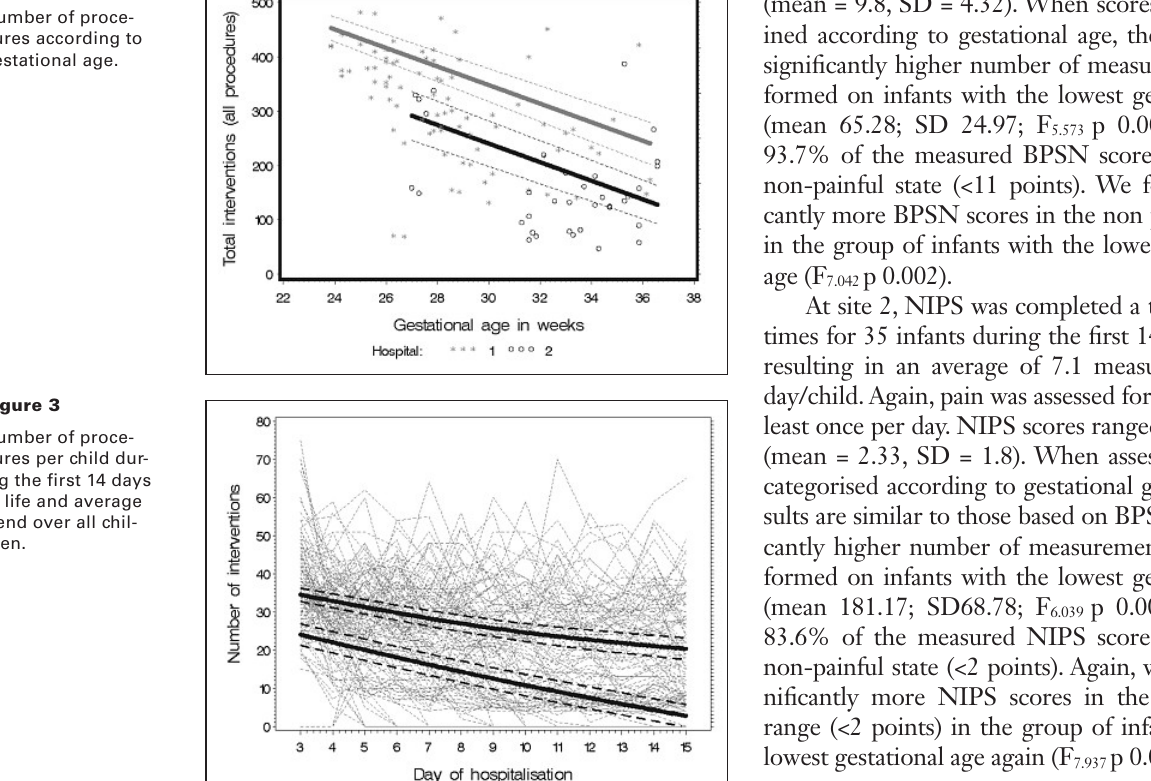
Number of proce- dures according to gestational age.